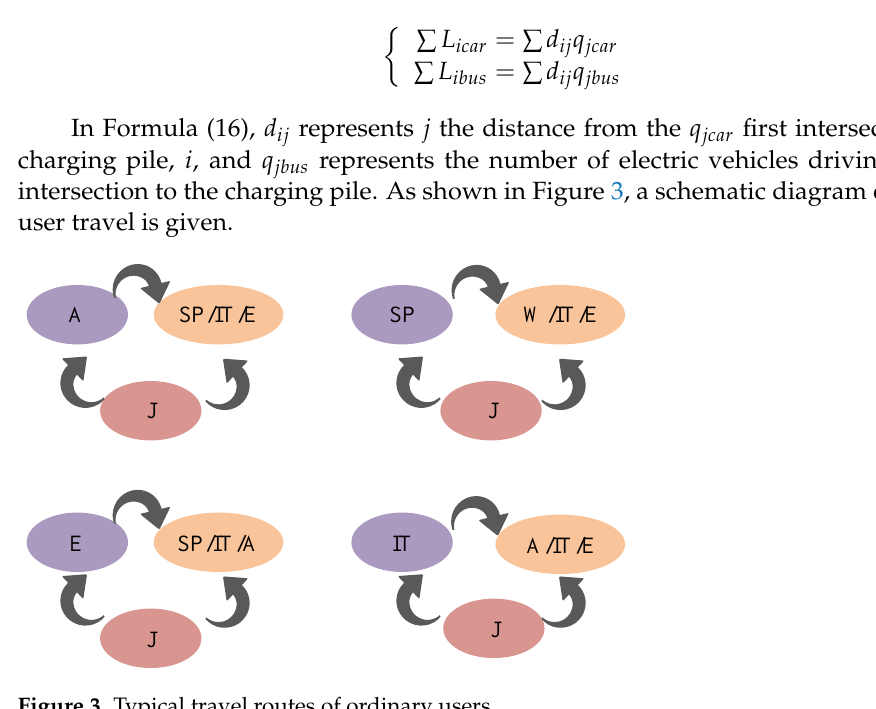
Figure 3. Typical travel routes of ordinary